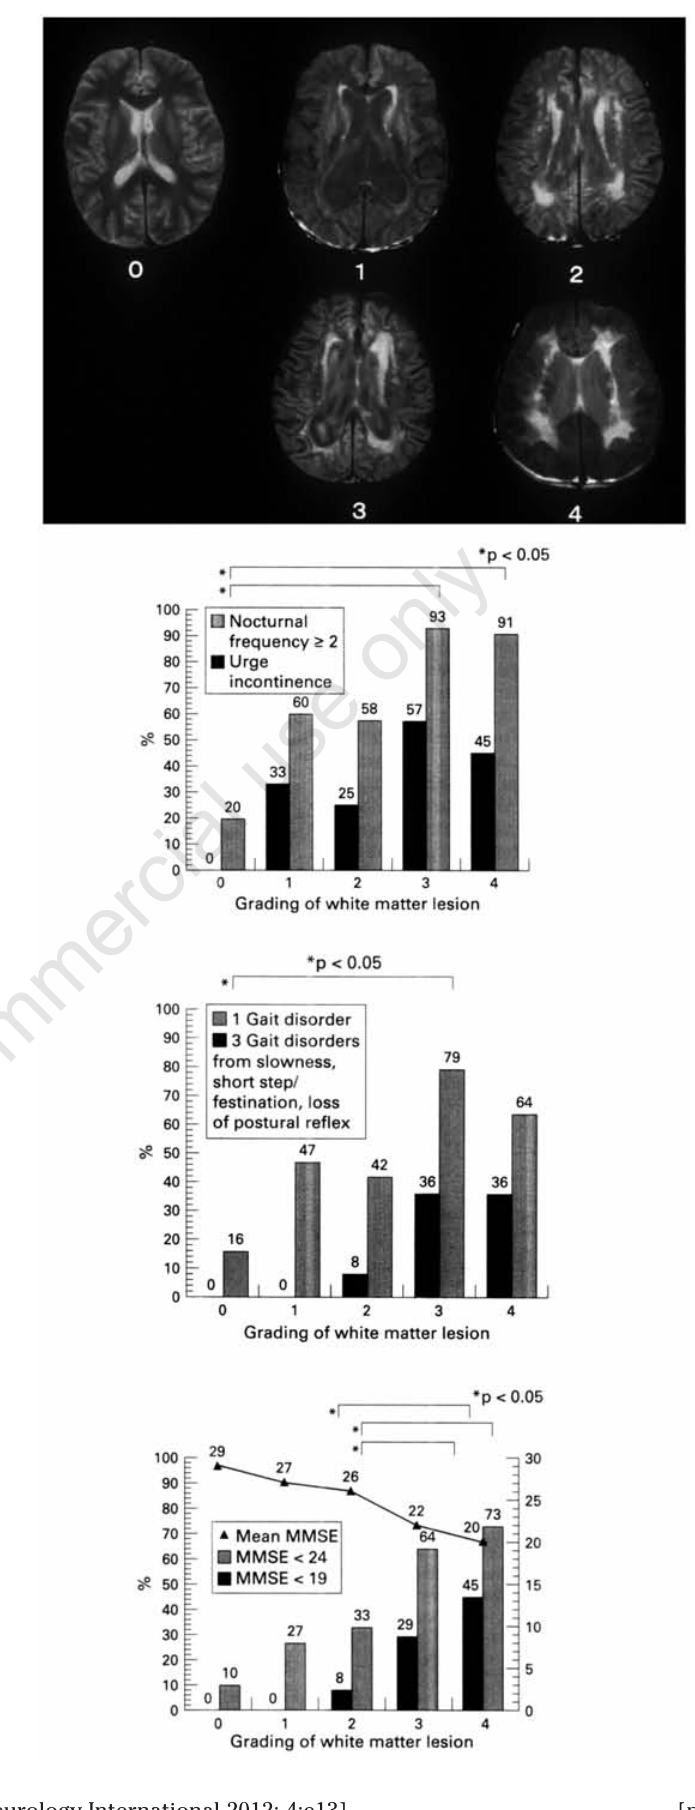
Figure 1. Cerebral white-matter changes and urinary dysfunction. Schematic presen- tation of the grading of white-matter lesions on MRI: Grade 0, none. Grade 1, punctate foci with high signal intensity in the white matter immediately at the top of the frontal horns of the lateral ventricles. Grade 2, white-matter lesions were seen elsewhere but remained confined to the immediate subependymal region of the ventricles. Grade 3, periventricular as well as separate, discrete, deep white-matter foci of signal abnormality. Grade 4, discrete white-matter foci had become large and coalescent. Graphs: urinary dysfunction and white- matter lesions on MRI; cognitive disorder and white-matter lesion on MRI. MMSE: mini-mental state examination. Gait disor- der and white-matter lesion on MRI. Reproduced with permission.